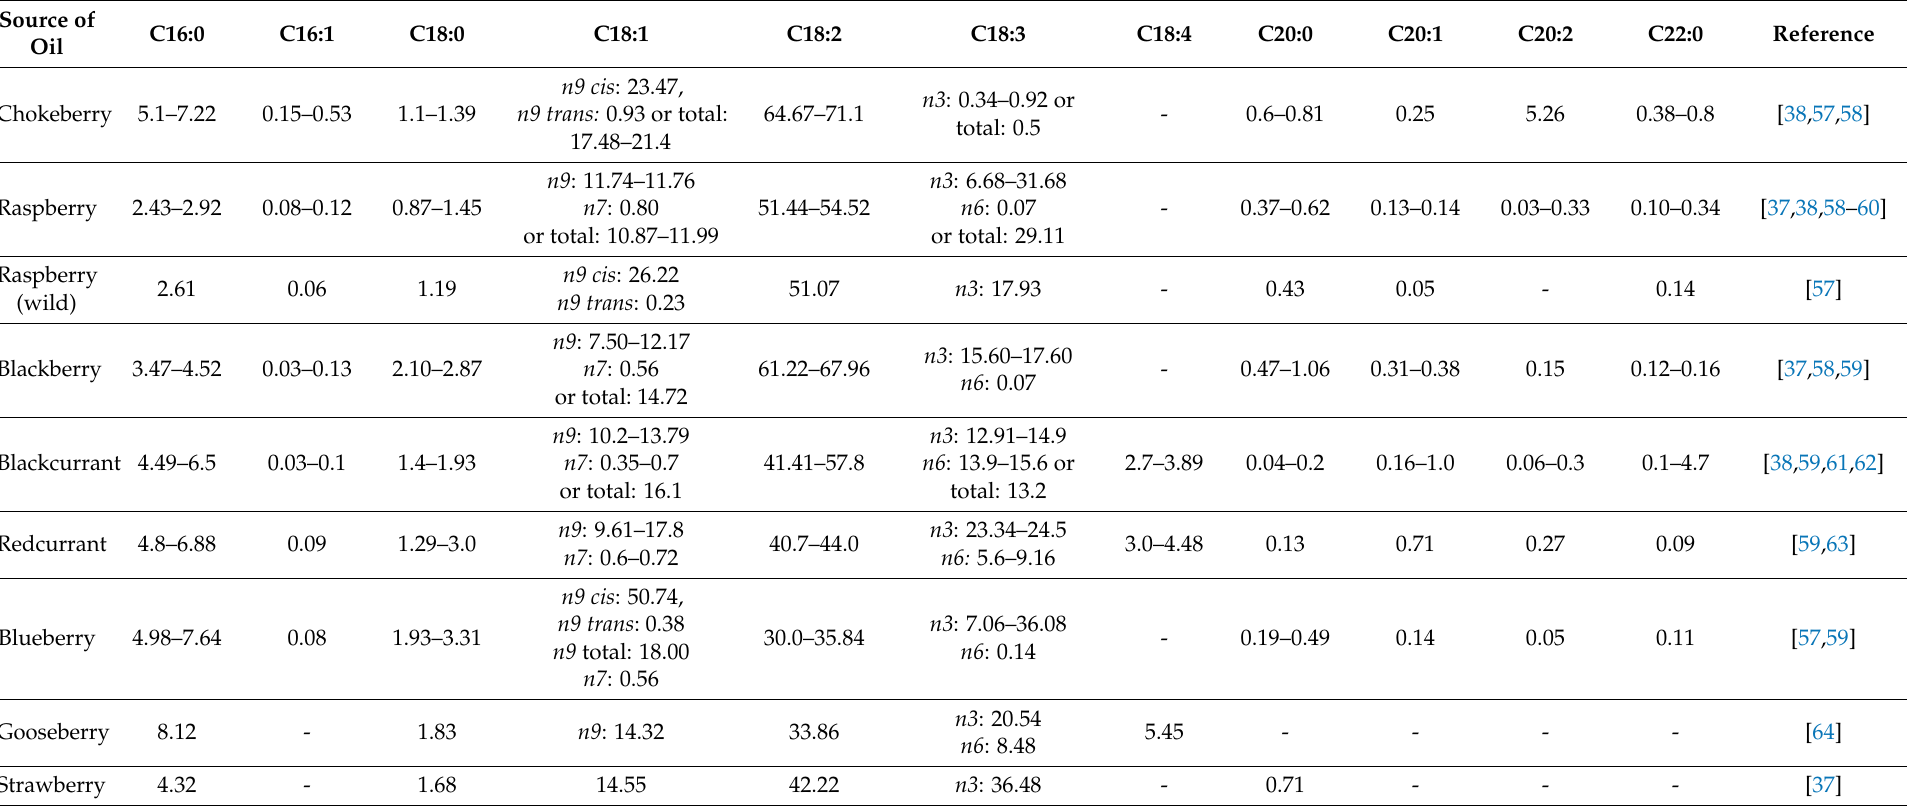
Table 1. Fatty acid profiles (%) of oils extracted from berry pomaces. (C16:0—palmitic acid, C16:1—palmitoleic acid, C18:0—stearic acid, C18:1—oleic